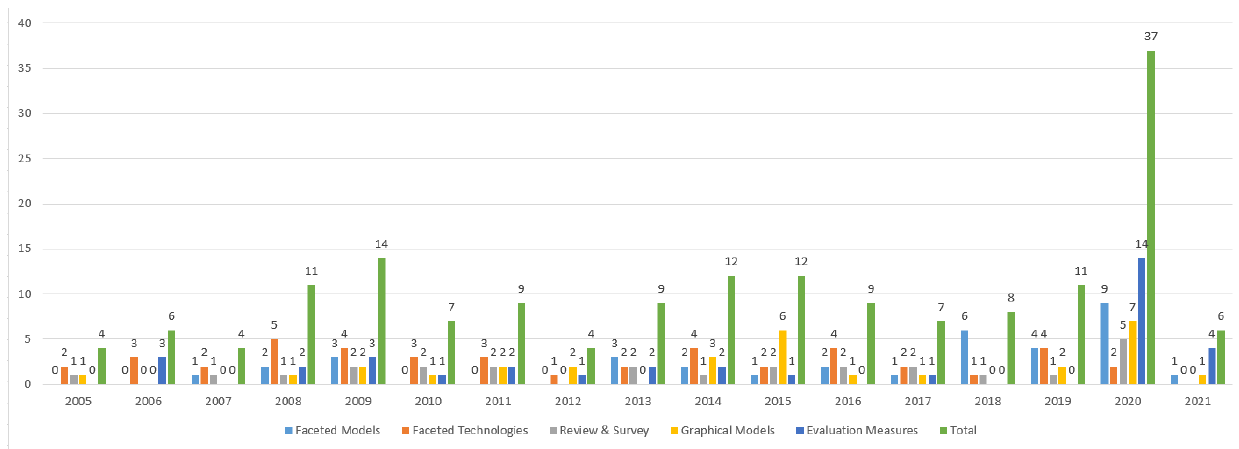
Figure 5. Articles published between 2005 and